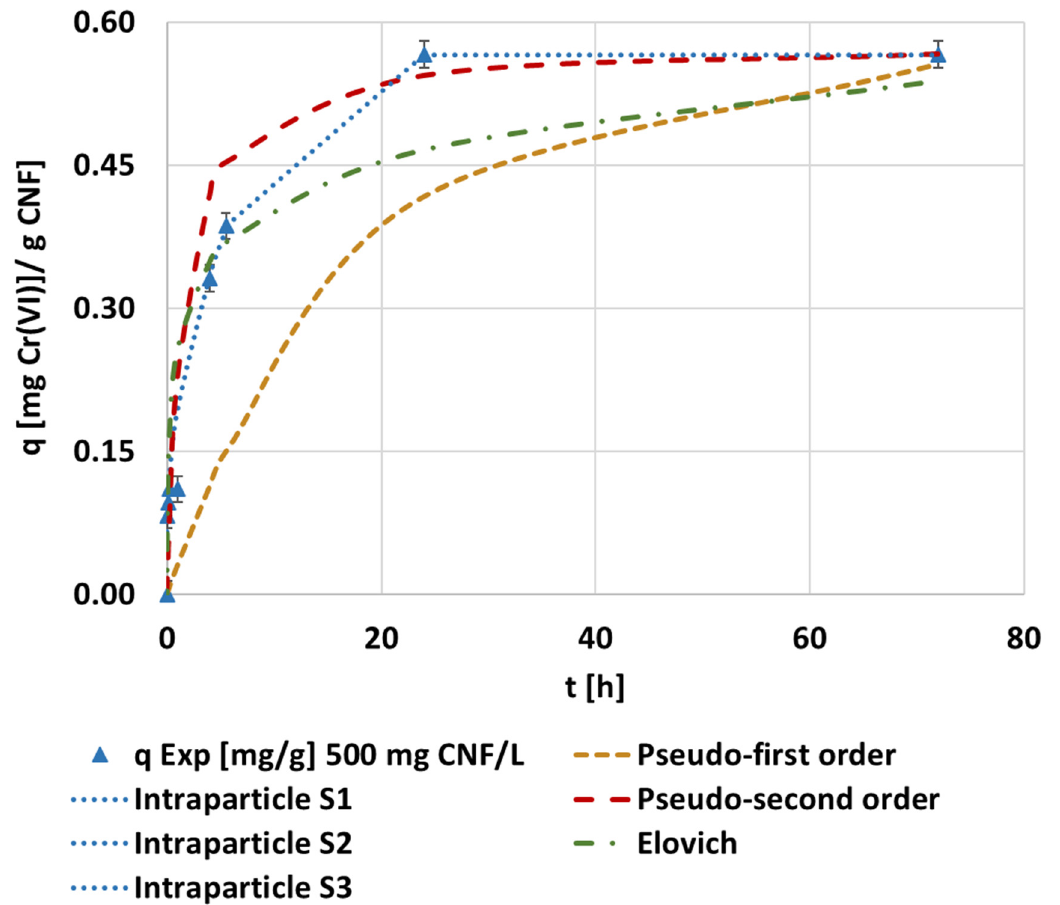
Figure 8. The evolution of the kinetic adsorption experiment at 0.1 mg · L − 1 of the chromium initial concentration, 1.5 mmol MTMS · g − 1 CNF, and pH 3 conditions under 500 mg CNF · L − 1 of dosage and the kinetic fitting of the pseudo-first, pseudo-second, Elovich, and intraparticle models.